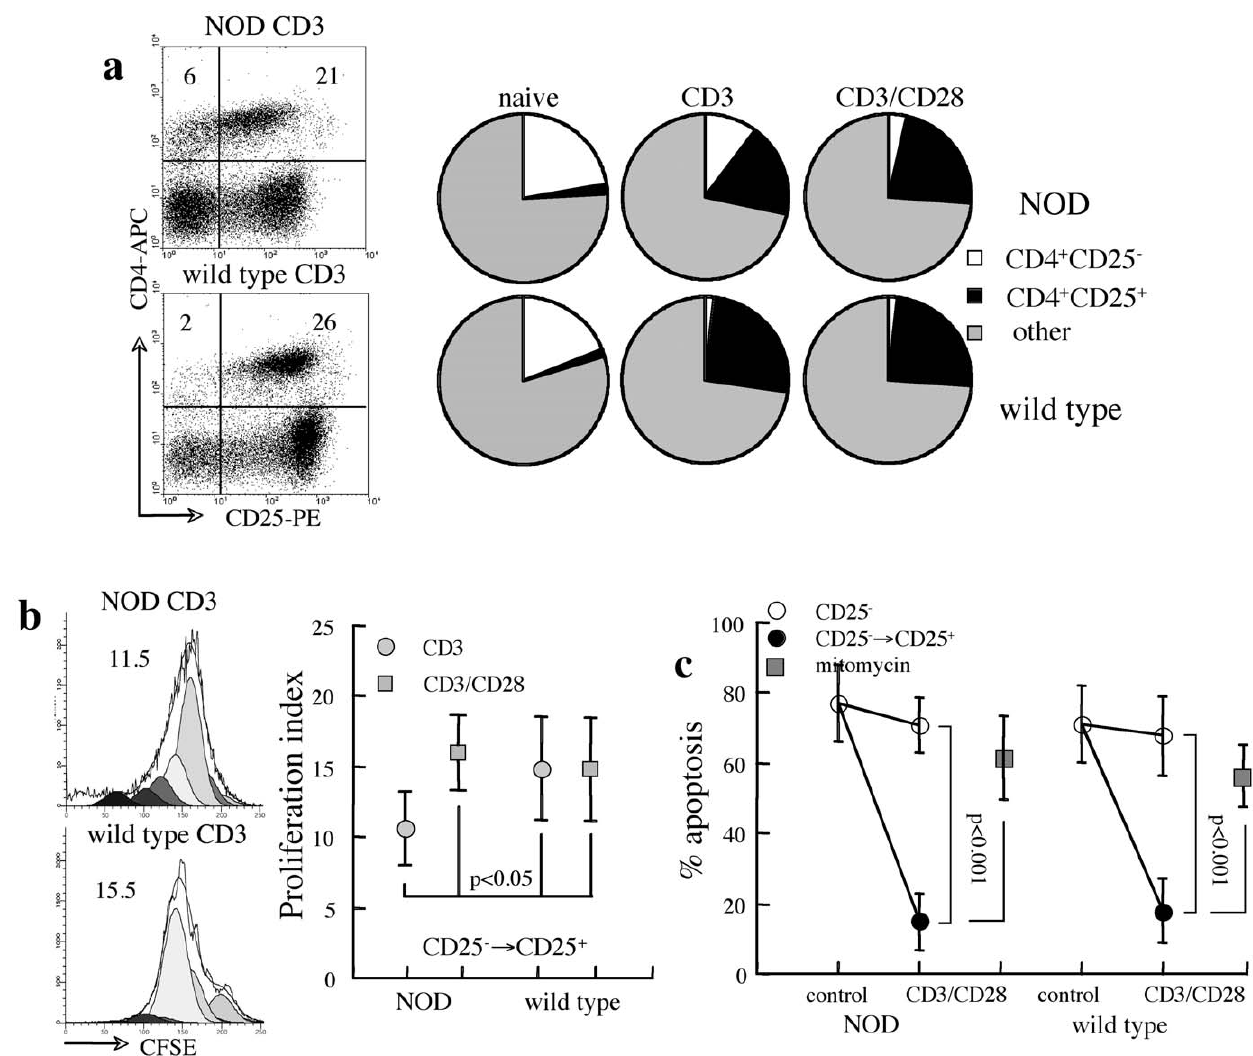
Figure 4. Sensitivity to apoptosis under CD3 and CD3/CD28 stimulation. A. Representative plots of CD25 upregulation under CD3 stimulation in splenocytes from NOD and wild type mice. Quantitative conversion to express CD25 in splenocyte cultures from NOD (n=4) and wild type females (n=6) under CD3 and CD3/CD28 stimulation as compared to unstimulated cultures (naı¨ve). Other delineates all CD4 2 cells. B. Proliferation rates of CD4 + T cells that upregulated CD25 expression (CD25 2 R CD25 + ) as determined from CFSE dilution in mixed cultures of splenocytes from NOD (n-4) and wild type mice (n=5) under CD3 and CD3/CD28 stimulation. C. FasL-induced apoptosis in reference to CD25 expression in gated CD4 + T cells within mixed splenocyte cultures from NOD and wild type mice (n=4) under CD3/CD28 stimulation. Apoptosis was also measured under inhibition of proliferation with Mitomycin C (n=3).